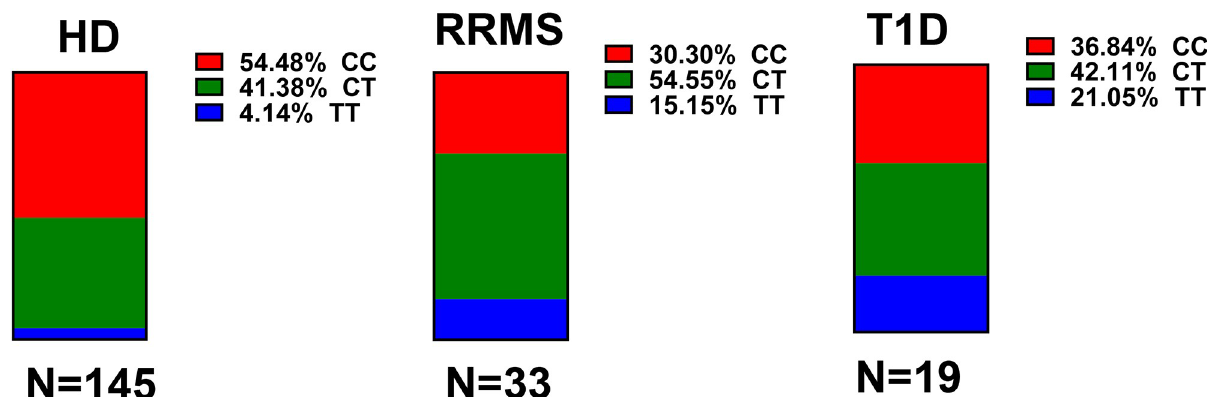
Fig 1. As compared to HD, RRMS and T1D patients show significantly greater preponderance of rs2281808 CT/TT carriers. DNA samples from healthy donors (HD), relapsing remitting multiple sclerosis (RRMS) and type 1 diabetes (T1D) were genotyped for SNP rs2281808 by TaqMan assay. Distribution of CC, CT and TT genotypes in study populations is shown in A. Comparison of CC, CT and TT genotype within the three study populations is shown in B. Both RRMS and T1D patients showed a significant preponderance of CT/TT carriers as compared to HD. Chi-Square test was used to compare the genotyping data and p < 0.05 was considered